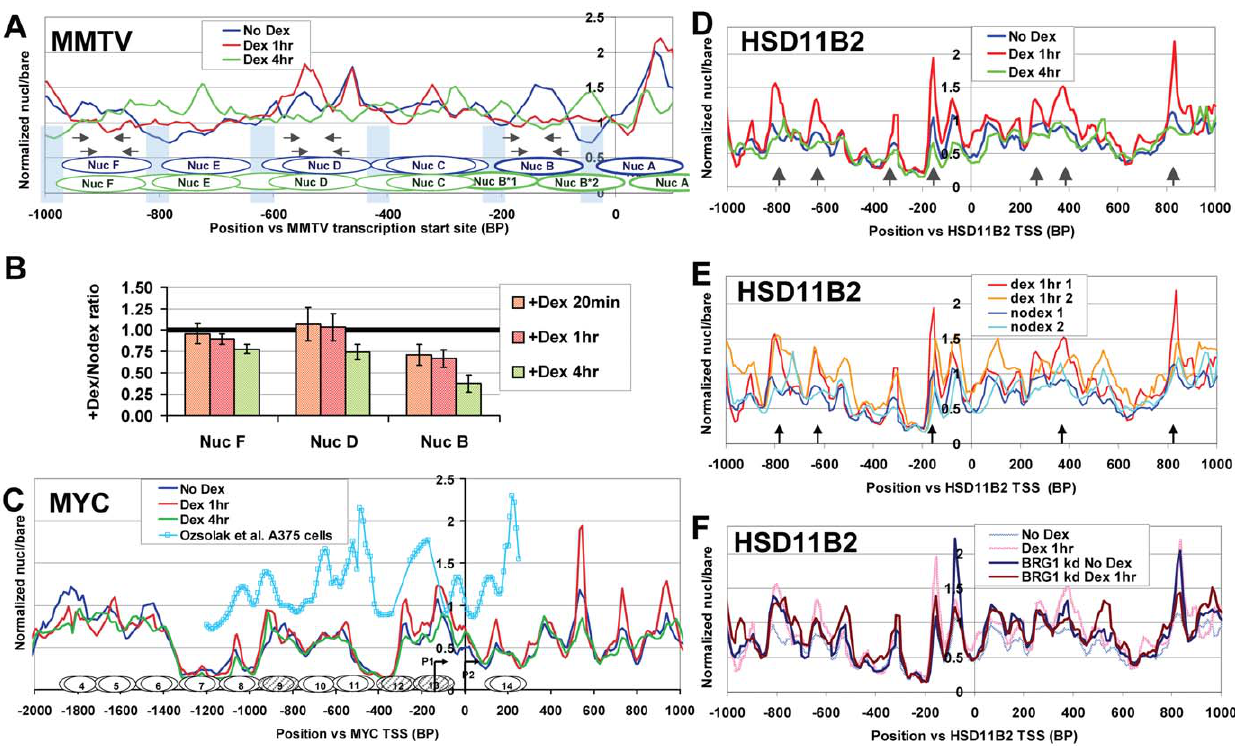
Figure 2. Hormone addition results in chromatin changes at individual GR-regulated genes. UL3 cells were transfected with BRG1- specific or control siRNA oligos, and treated, after 71 hours with 10 nM Dex (or ethanol vehicle) for 1 hr. Alternatively, untransfected cells were treated with Dex for 4 hrs. ( A ) Quantile normalized nucleosome/bare ratios for the MMTV LTR promoter region from the integrated MMTV-luciferase construct for No Dex (blue line), Dex 1 hr (red line) or Dex 4 hrs (green line). Blue bars: approximate locations of nucleosome boundaries from indirect end labeling experiments [19,48]. Blue & green ovals: nucleosome positions for No Dex or Dex 4 hrs. Arrows: primer sets used to detect Nucs B, D & F for Fig. 2B. We calculate that a nucleosome/bare ratio of 1.0 corresponds to , 50% nucleosome occupancy, while a value of 2.1 corresponds to 100% occupancy (e.g. a nucleosome covering a given location on all gene copies). Because a nucleosomal fragment must cover the full length of each oligo to give a strong signal, well positioned nucleosomes are represented by signal peaks greater than 1.0 and spanning only about 9 oligos ( , 90 bp), an effect which also increases the apparent width of nucleosome-free linker regions. For more details, see Additional Methods, in Text S1. ( B ) MNase footprint PCR results for MMTV, using the primer sets indicated in (A). The PCR signal from mononucleosomal fragments at the indicated positions and times after Dex addition was normalized by dividing by the NoDex signal, and the results from both pairs of primers corresponding to each position averaged. Bars indicate standard error of the mean from 6 PCR reactions. In addition to the progressive decrease at Nuc D at 20 mins, 1 hr and especially 4 hrs, moderately decreased signal at Nucs D and F was also seen at 4 hrs (consistent, perhaps, with the somewhat lower occupancy, especially for Nuc D, seen in Fig. 2A). ( C ) As for (A), but showing the nucleosome profile for the Dex-repressed endogenous MYC promoter. Ovals indicate nucleosome positions mapped using indirect-end labeling in human HL60 cells [51,52,53]. The light blue line and squares shows array mapping results from A375 cells ([6], GEO # GSE6385). Arrows show the minor (P1) and major (P2) MYC promoters. ( D ) As for (A), but showing results for the Dex-induced endogenous HSD11B2 promoter. Grey arrows indicate sites where nucleosome occupancy increases or decreases after 1 hr of dex treatment. ( E ) Comparison of No Dex and Dex 1 hr experimental results from two separate experiments. Conditions for the second experiment were identical, except that cells were not transfected with control siRNA oligos before hormone treatment. Arrows indicate sites of statistically significant nucleosome occupancy changes. We found that almost all locations that met this criterion for experiment # 1 (e.g. dark blue and red curves at arrows) showed an occupancy difference in the same direction in experiment # 2 (e.g. blue-green and orange curves at arrows). ( F ) No Dex and Dex 1 hr treatments in BRG1 knock down cells (dark blue and dark red lines). The data from control transfected cells (from (D)) is shown